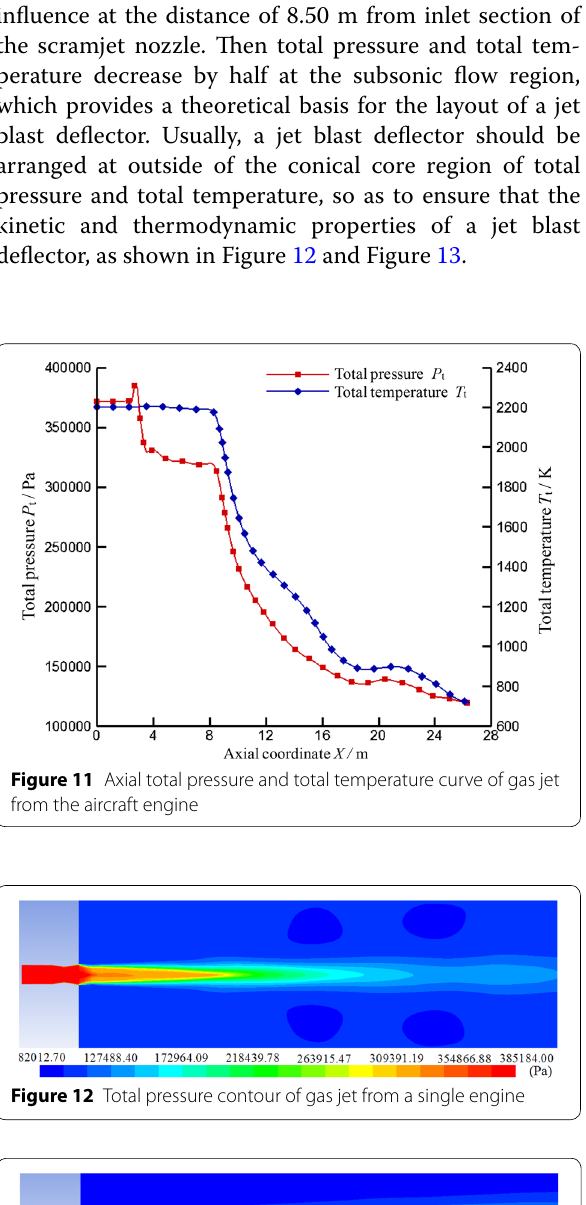
Figure 8 Static pressure contour of gas jet from a single engine